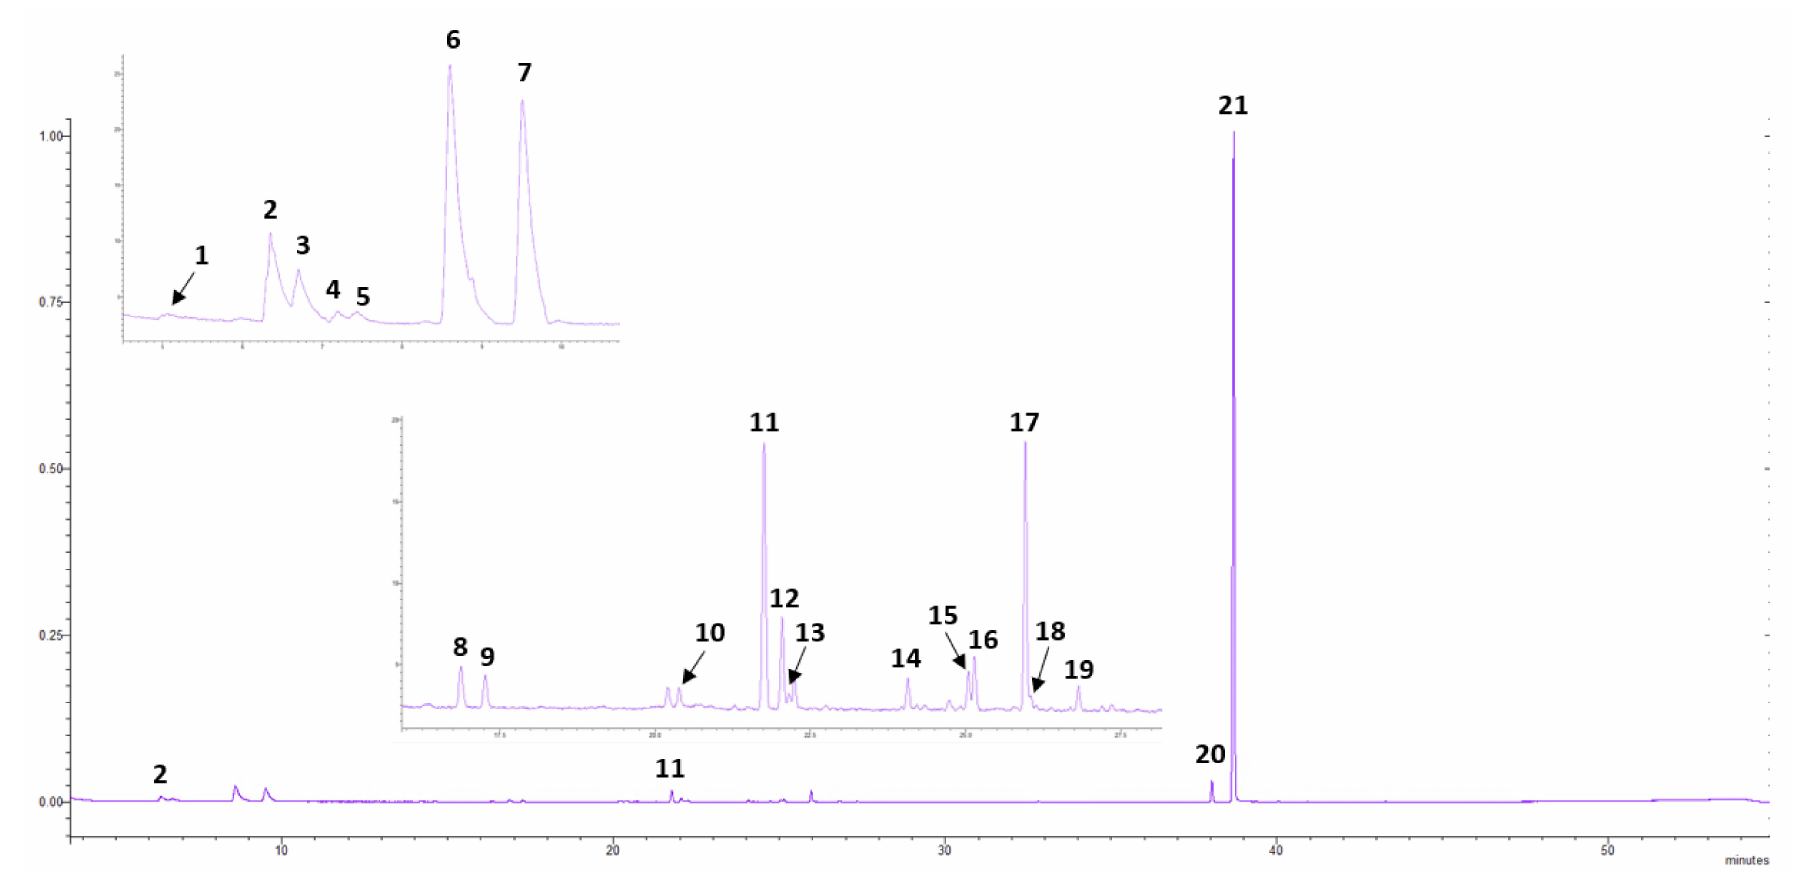
Figure 1. Typical GC-MS total ion chromatogram (TIC) of oregano’s headspace part of the essential oil. The numbers in the insets represent the detected components: (1) β -pinene, (2) β -myrcene, (3) α -terpinene, (4) limonene, (5) β -phellandrene, (6) γ -terpinene, (7) p-cymene, (8) 1-octen-3-ol, (9) 4-thujanol, (10) linalool, (11) β -caryophyllene, (12) terpinen-4-ol, (13) dihydrocarvone, (14) α -caryophyllene, (15) α -terpineol, (16) endo-borneol, (17) β -bisabolene, (18) carvone, (19) δ -cadinene, (20) thymol, (21)